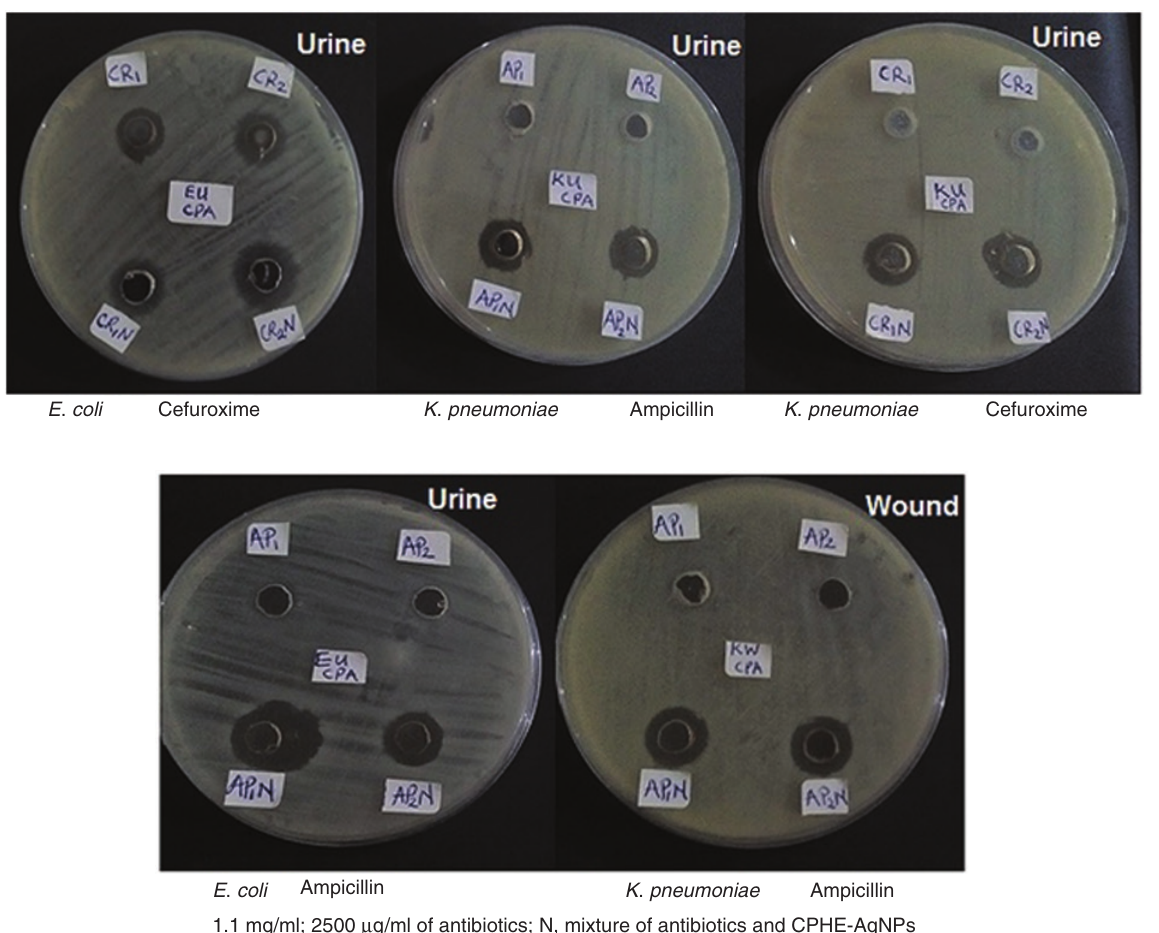
Figure 3: Synergistic activities of synthesized CPHE-AgNPs with ampicillin and cefuroxime on some clinical bacterial